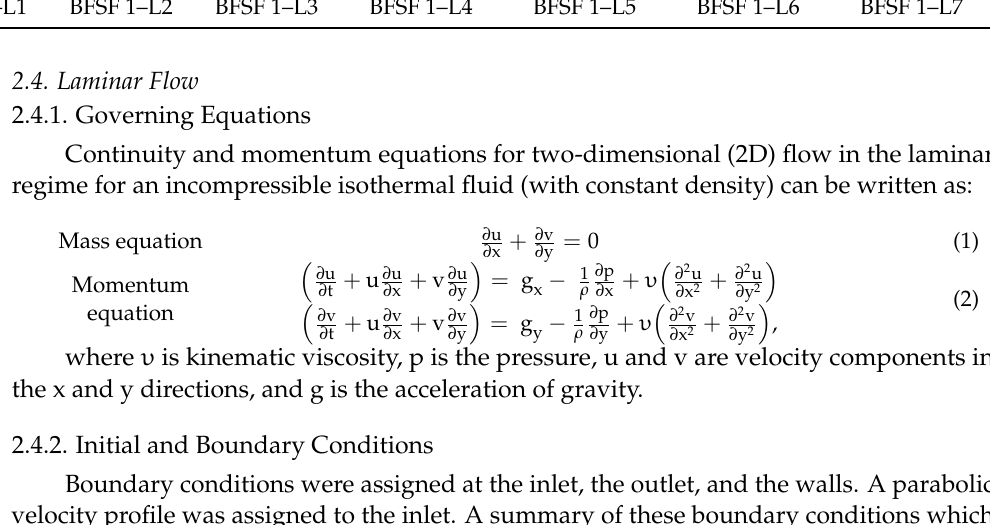
Table 3. Boundary conditions of the backward-facing step in the laminar